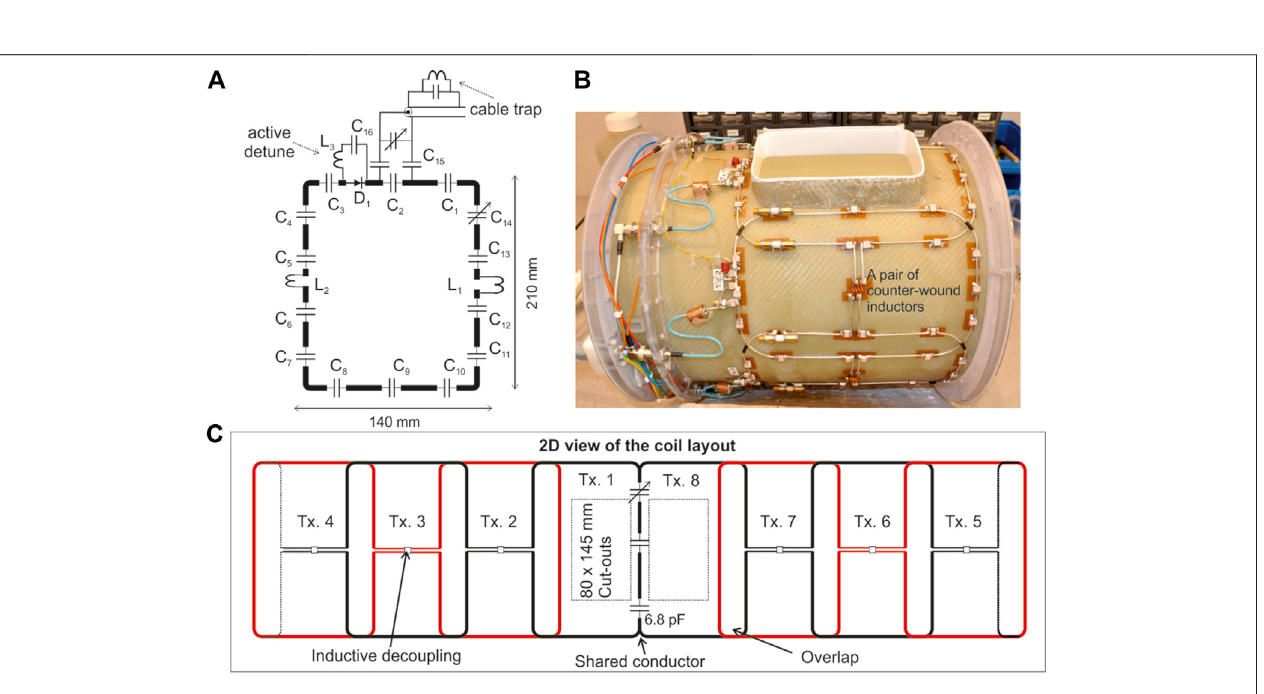
FIGURE 2 | (A) Equivalent circuitofa single element of the transmitarray consisting of 13 × 6.8 pF fi xed capacitors (C 1 to C 13 ) and atrimmer capacitor C 14 to fi ne- tune the coil resonance frequency to 297.2 MHz. (B) Picture of the completed transmit array. (C) A two dimensional view of the transmit array con fi guration. The capacitor distribution in the shared conductor is also